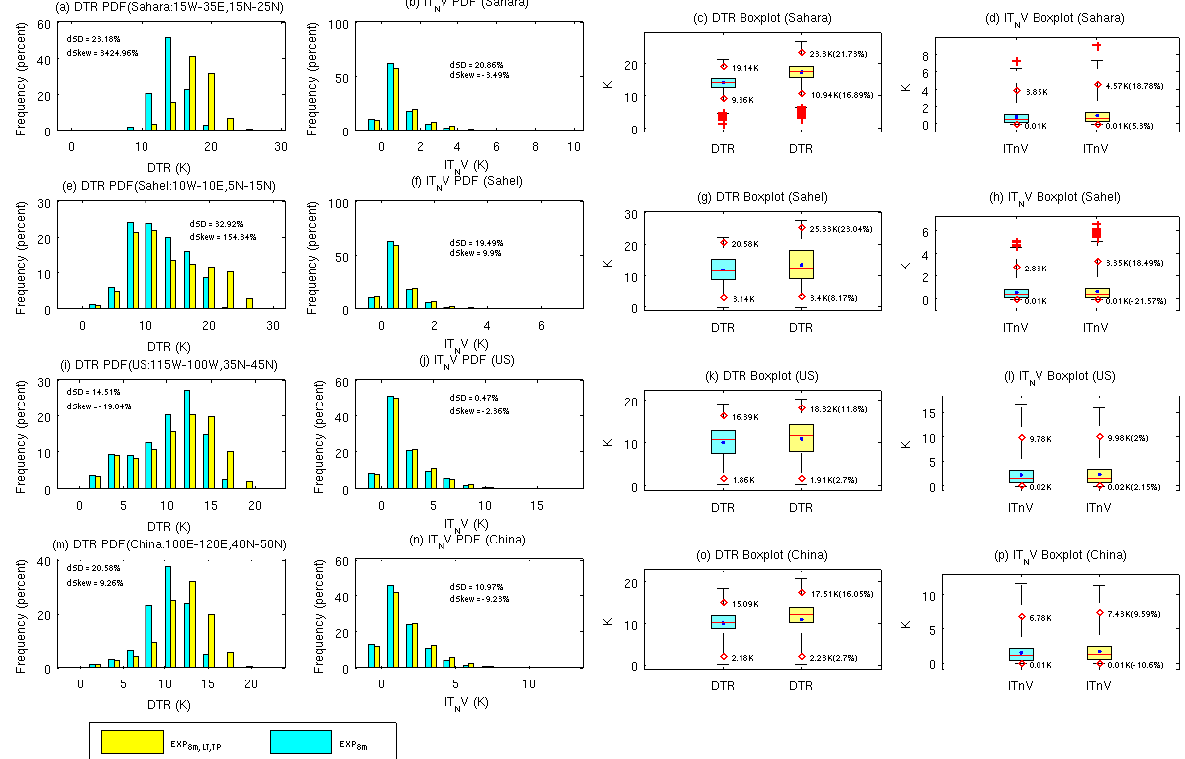
Figure 10. The probability density function (PDF) for DTR (1 column) and IT N V (2 column), and the box plot of DTR (3 column) and IT N V (4 column) over the Sahara (1 line), the Sahel (2 line), the central US (3 line), and North China (4 line) between EXP 8m , LT,TP (in yellow) and EXP 8m (in blue) with daily values. The grid point value is weighted by its areas. In the box plot, the red central mark and the blue dot are the median and mean, and the edges of the box and the 25 and 75 percentiles. The whiskers extend to the most extreme data points not considered outliers. Points are drawn as outliers if they are larger than X 25th + 3 · (X 75th − X 25th ) or smaller than X 25th − 3 · (X 75th − X 25th ), where X 25th and X 75th are the 25 and 75 percentiles, respectively. The red diamond and the values are the 99 and 1 percentiles. The percentage (%, dSD, dSkewness in PDF; values in brackets in box plot) measures the difference between the